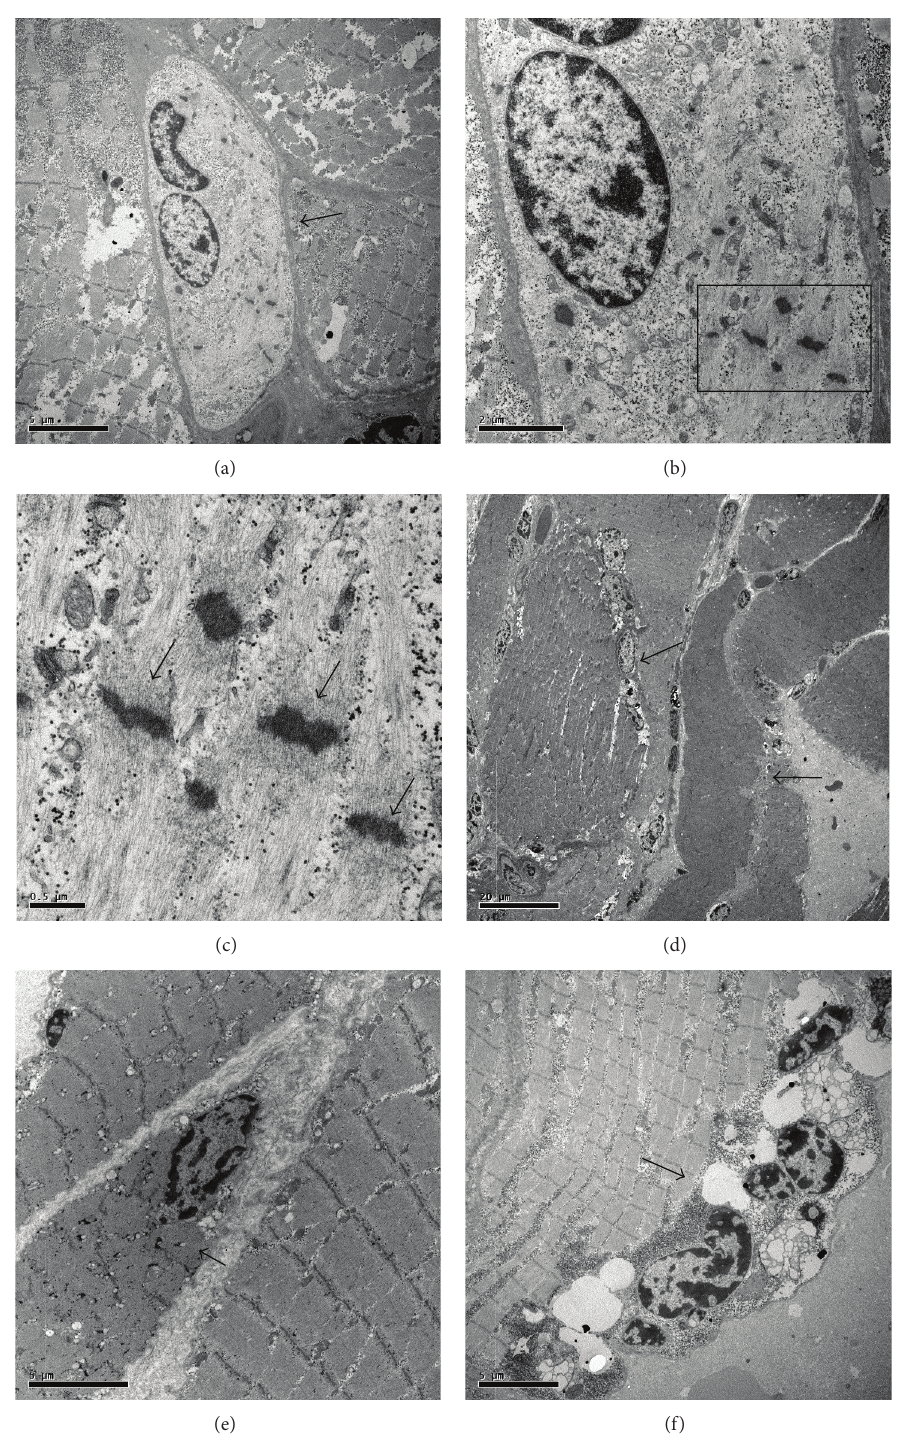
Figure 4: Transmission electron microscopy analysis of muscle stem cells. TEM analysis was performed to identify satellite cells according to their ultrastructural characteristics. In OA muscle biopsies we found several satellite cells generally placed between normal and degenerated fibers. In satellite cells syncytium (a) (arrow) we observed de novo production of sarcomeric structure (arrows) (10.000x and 50.000x) ((b)- (c)). TEM analysis of muscle biopsies from OP patients showed numerous degeneration areas (arrows) (2.500x and 5.000x) ((d)-(e)). Rare satellite cells syncytia (arrow) with obvious mark of degeneration, such as nuclear anomalies and vacuolations, we found in OP patients (5.000x)